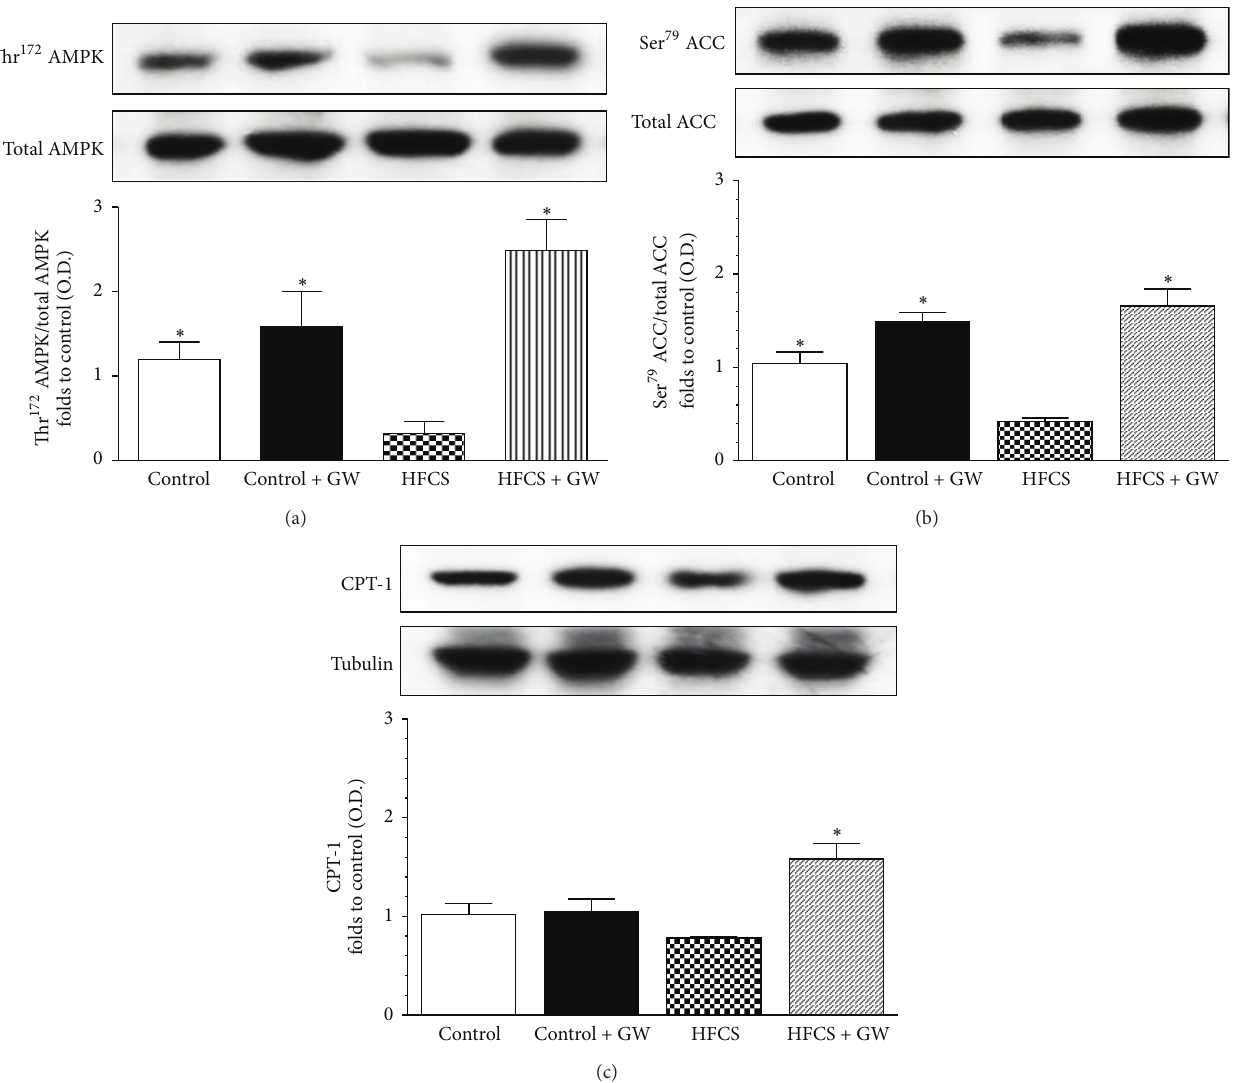
Figure 5: Effects of GW0742 treatment on AMPK/ACC phosphorylation and CPT-1 expression in the gastrocnemius of mice fed with HFCS diet. Total AMPK protein expression and Thr 172 phosphorylation (a), total ACC protein expression and Ser 79 phosphorylation (b), and CPT-1 expression (c) were analyzed by western blot on the gastrocnemius homogenates obtained from mice fed with a standard (control) or HFCS diet (HFCS) for 30 weeks and treated with GW0742 (1mg/kg/day) added during the last 16 weeks (control + GW; HFCS + GW). Densitometric analysis of the bands is expressed as relative optical density (O.D.), corrected for the corresponding tubulin contents, and normalized using the related control band. The data are means ± SD of three separate experiments. ∗ 𝑃 < 0.01 versus